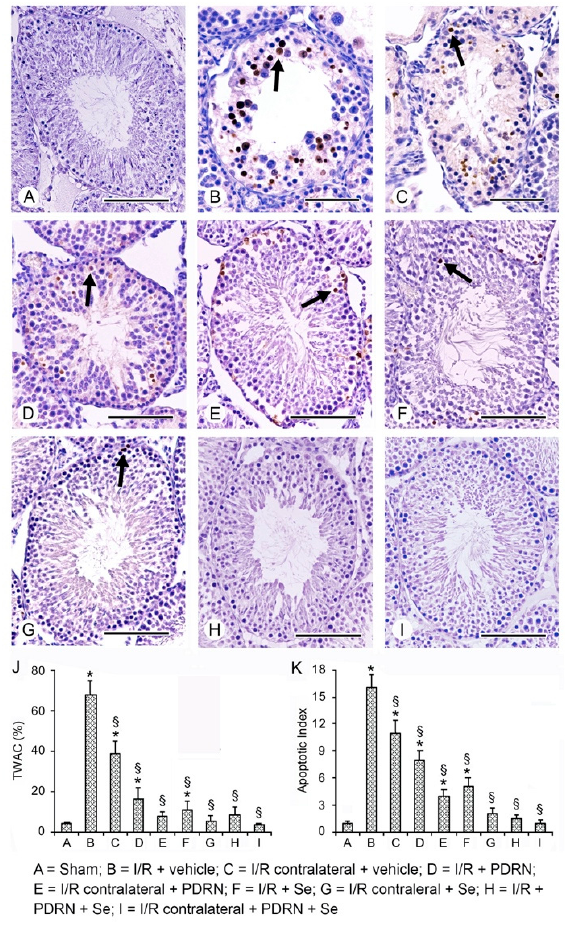
Figure 3. Assessment of apoptosis in the different groups of rat testes with TUNEL stain. ( A ) In the testes of all sham rats, no TUNEL-positive cells were present. ( B , C ) Many TUNEL-positive cells (arrow) were seen in the wall of the seminiferous tubules of I/R + vehicle rats and in CL testes of the same group. ( D , E ) In I/R + PDRN alone-treated rats and in the CL tests of the same group, TUNEL-positive cells (arrow) were decreased when compared with I/R rats. ( F , G ) In I/R + Se-treated rats and in CL testes of the same group, only isolated TUNEL-positive cells were present. ( H , I ) In I/R rats treated with the association PDRN + Se, in both operated and CL testes, only rarely isolated TUNEL-positive germ cells were observed. ( J ) Tubules with apoptotic cells (TWAC) (expressed in %) in the different groups of rats. ( K ) Apoptotic index (apoptotic cells/tubule) in the different groups of rats. * p ≤ 0.05 versus sham group; § p ≤ 0.05 versus I/R rats (scale bar: ( A , D – I ) = 100 µ m; ( B , C ) = 50 µ